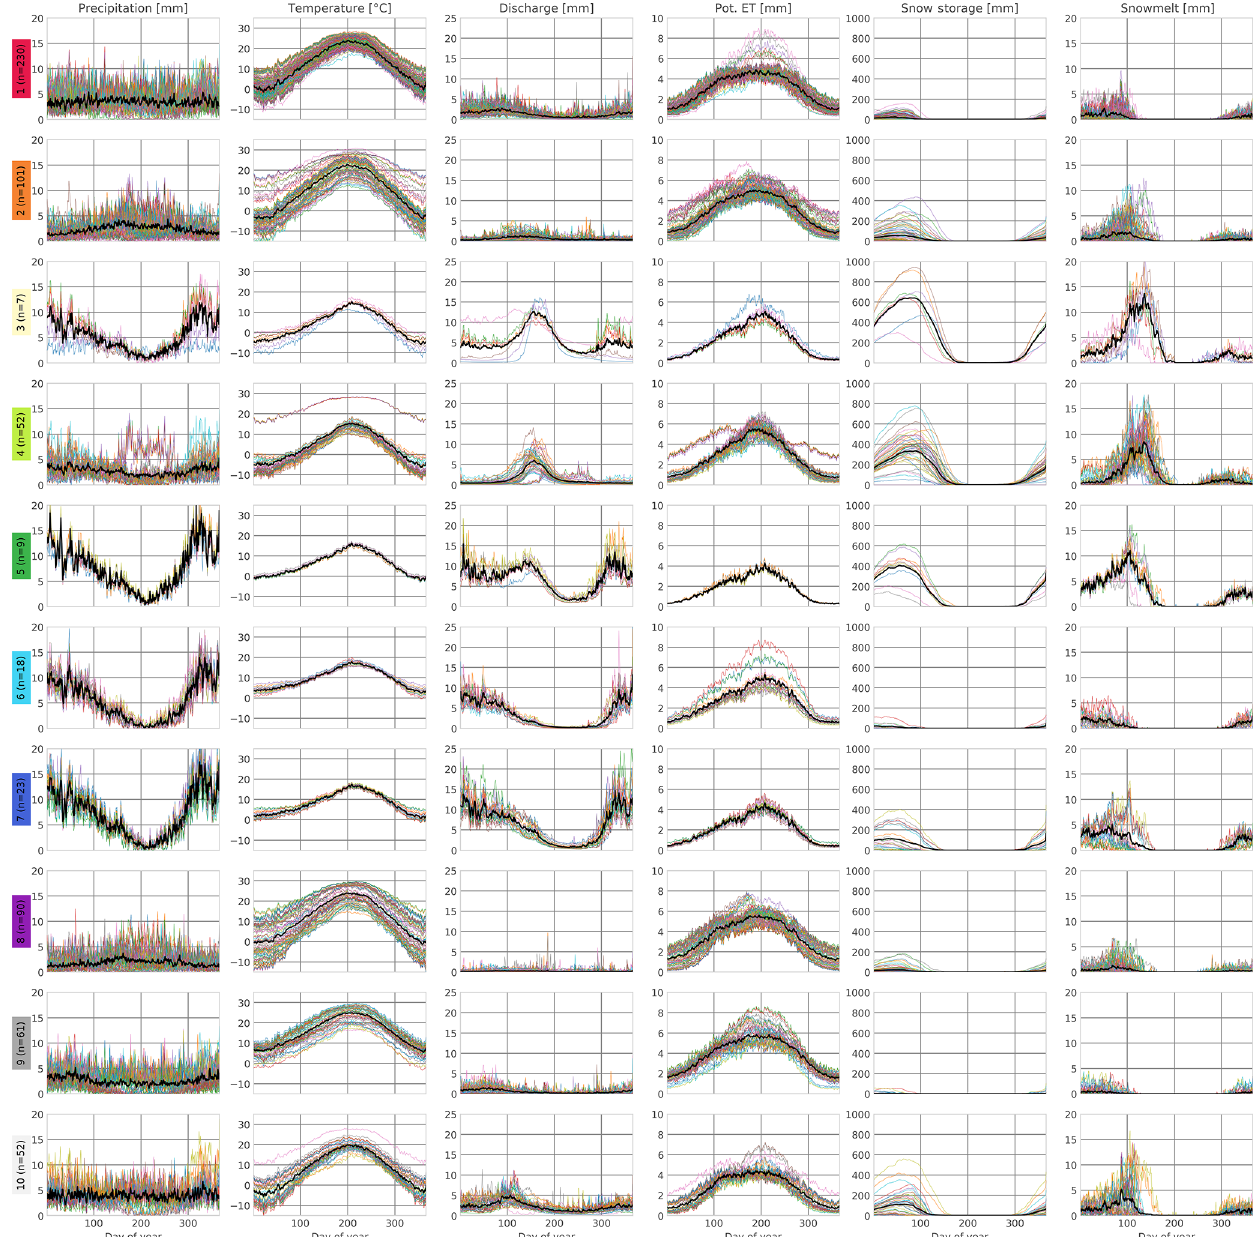
Figure 6. Meteorological attributes of the clustered CAMELS catchments averaged by day of the year. Potential evapotranspiration (Pot. ET) was calculated with Hargreaves–Samani (Samani, 2000). Snow storage and melting was calculated using a temperature-based approach described in Massmann (2019). Black lines indicate the mean of all cluster members. Colored lines represent the individual catchments.